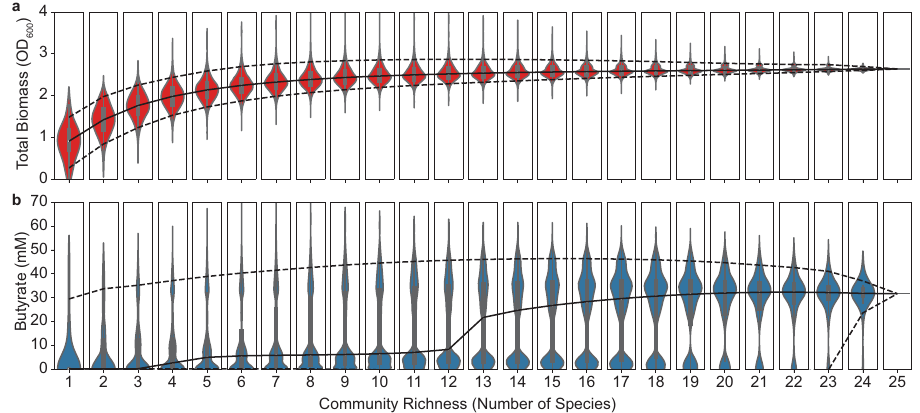
Fig. 5 Predicted biodiversity – ecosystem function relationships for total biomass and butyrate production. Violin plots showing the distribution of predicted ( a ) total biomass or ( b ) butyrate concentration for all possible communities at each richness level. Solid lines indicate the median and dashed lines indicate the 5th and 95th percentiles of each distribution ( n at each community richness value is equal to 25 choose k , where k is the